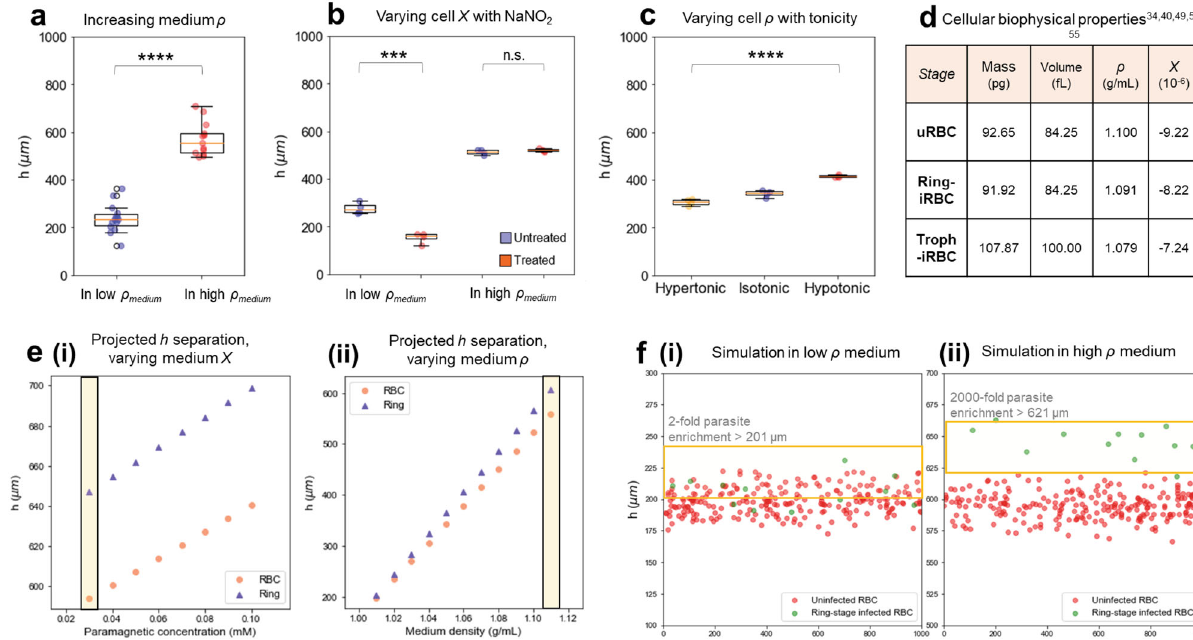
Fig. 2 Levitation changes from independent variations in density and magnetic susceptibility, and theoretical predictions of levitation heights of cell types under different conditions, based on reported and estimated values of cell densities and magnetic susceptibilities. h refers to levitation height ( µ m), Χ refers to magnetic susceptibility (unitless), and ρ refers to density (g/mL). RBC to red blood cells, or erythrocytes, uRBC refers to uninfected RBCs, ring-iRBC to ring-stage synchronized infected RBCs, and troph-iRBC to trophozoite-stage infected RBCs. a Increasing the density ( ρ ) of the medium leads to increased levitation heights for the same cell type (uRBC). Low medium ρ data are in purple circles ( n = 14 independent samples), and high medium ρ in orange circles ( n = 13 independent samples), with p = 2.4 × 10 − 12 . b uRBCs in levitation without treatment (purple circles) or with sodium nitrite (NaNO 2 ) treatment (orange circles) which converts the hemoglobin into the more paramagnetic methemoglobin. The experiment was conducted in low-density medium ( n = 4 distinct RBC population samples from donor blood aliquots in the untreated condition, and n = 4 in the treated condition) with p = 0.00029, and in high- ρ medium ( n = 4 untreated, and n = 4 treated) with p = 0.30. c Uninfected red blood cells in levitation, in solutions of varying tonicity and controlled ρ . Cells became more or less dense due to osmosis, with cells in hypertonic solution ( n = 3, yellow circles) becoming dehydrated and denser than in isotonic solution ( n = 3, purple circles), and cells in hypotonic solution ( n = 3, orange circles) becoming swollen and less dense than in isotonic solution, and their levitation heights behaving accordingly, with p = 9.6 × 10 − 7 . d Biophysical characteristics of RBCs in various stages of P. falciparum infection, as reported or estimated from measurements in literature (see Fig. S1 for more). e (i) Predicted heights of ring-iRBCs (purple triangles) and uRBCs (orange circles) at varying medium magnetic susceptibilities (modulated via the paramagnetic ion concentration (calculated at high medium ρ = 1.11 g/ mL)). The selected paramagnetic concentration is marked in a yellow box. (ii) Predicted heights of ring-iRBCs (purple triangles) and uRBCs (orange circles) at varying medium densities, showing increased separation in a high- ρ medium, marked in a yellow box (calculated at low medium Χ = 1.12 × 10 4 ). f Simulation of ring-stage synchronized infected culture at 5% parasitemia and diluted 1:100, (i) in a low- ρ medium (1.01 g/mL) at low Χ (1.12 × 10 4 ), where ring-iRBCs (green circles) are enriched twofold above h = 201 µ m (midpoint of the two cell types ’ projected heights); (ii) in a high- ρ medium (1.11 g/mL) at low Χ (1.12 × 10 4 ), where the concentration of ring-iRBCs is enriched 2000-fold above h = 621 µ m (midpoint of the two cell types ’ projected heights). uRBCs are shown as red circles. In a , b , Welch ’ s t -test was used to compare between groups. In c , ANOVA was used to compare across groups (asterisks indicate statistical signi fi cance across groups). * p < 0.05; ** p < 0.01; *** p < 0.001; **** p < 0.0001. Box plots represent upper and lower quartiles, with the center line marking the median, and the whiskers showing the range of the data. All experimentally measured samples are biologically